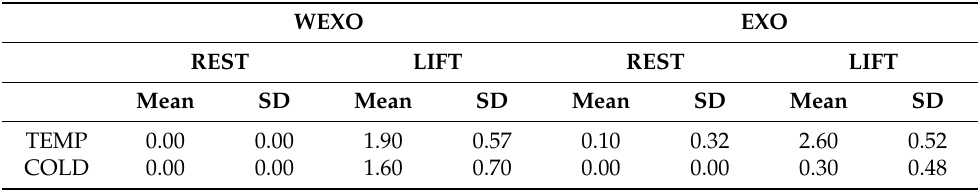
Table A5. Mean (SD) values of sweat feeling index during the experimental